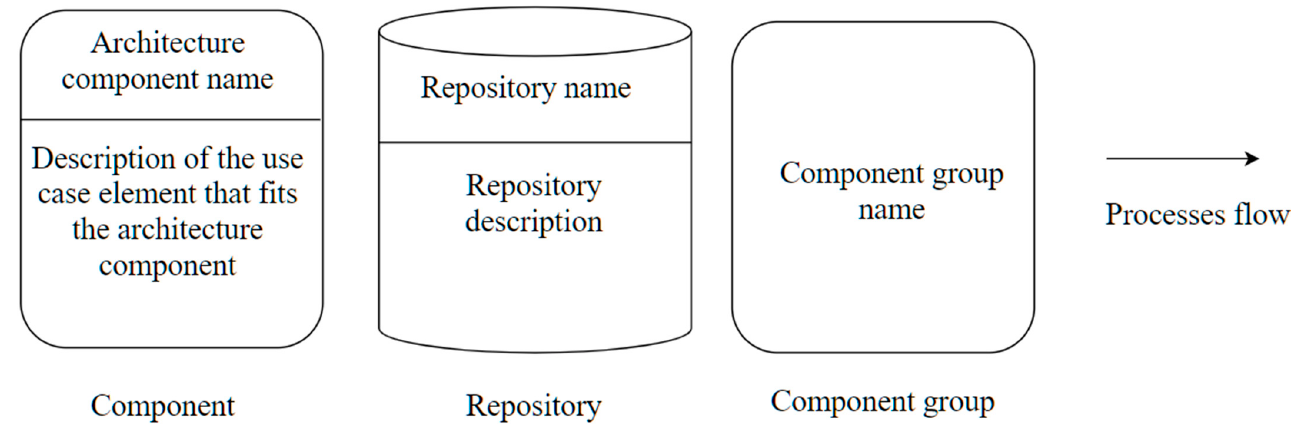
Figure 11. Notation icons for the elements of the process view diagram.